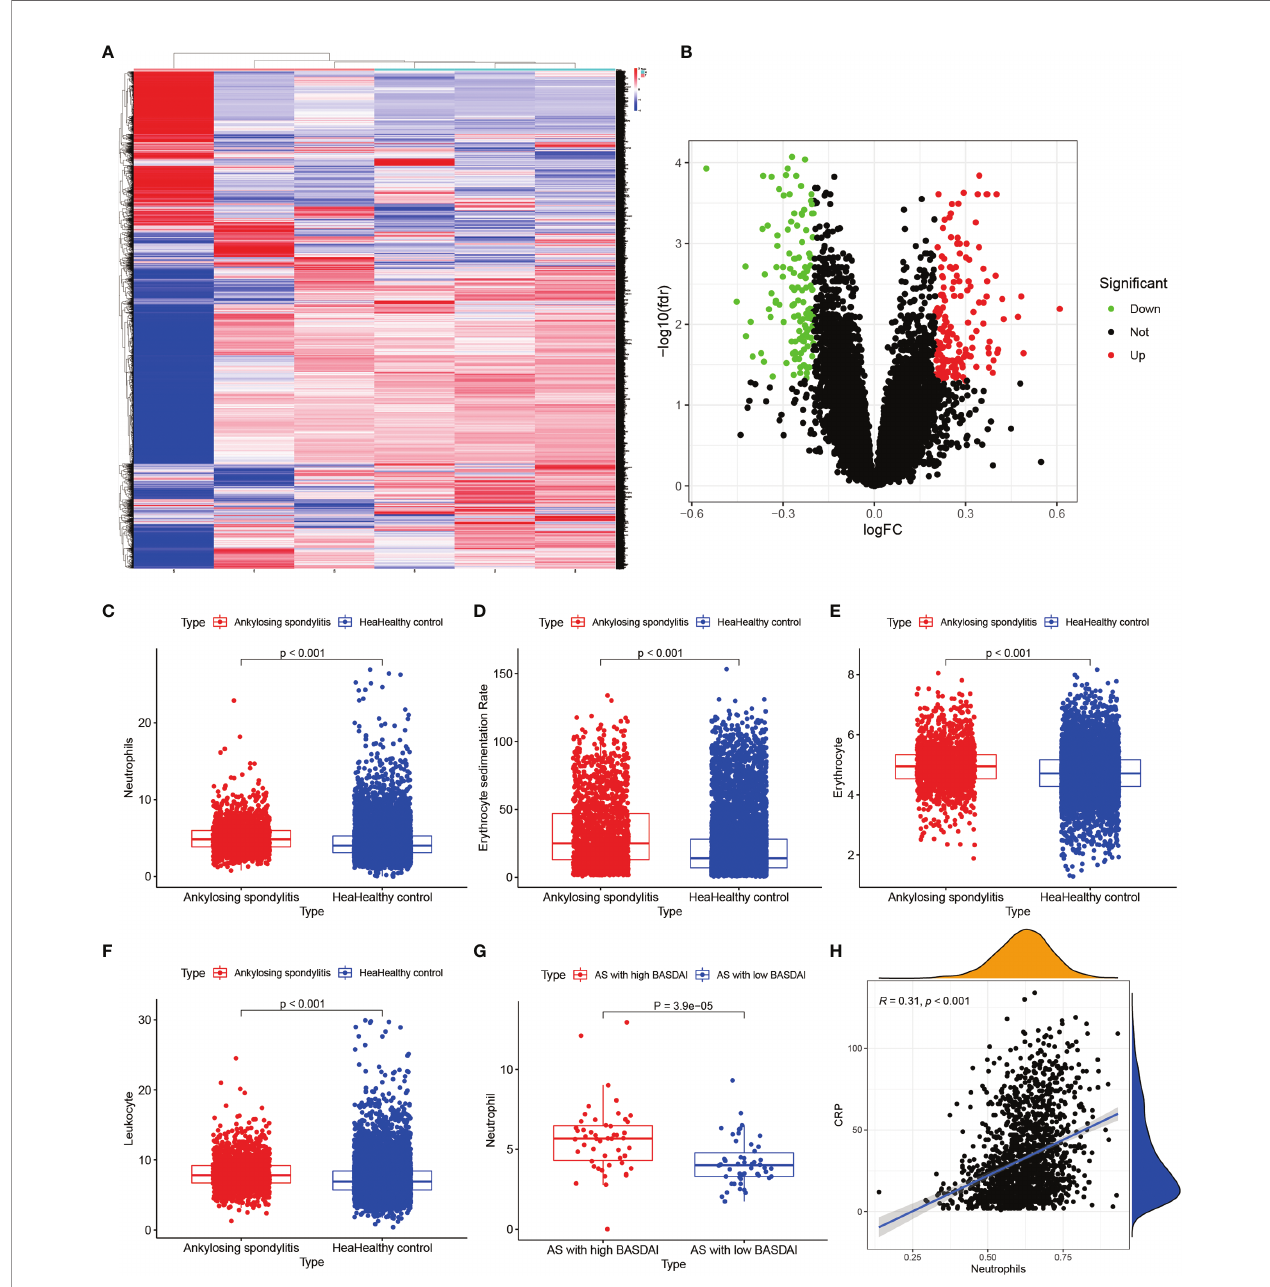
FIGURE 9 | Results of external validation sets are shown. (A, B) show heat and volcano maps of differentially expressed genes measured by high-throughput sequencing, con fi rming that ANXA3 and SORL1 are also differentially expressed genes in the interspinous ligament of AS. (C-F) show the variance analysis of the routine blood tests. (G) shows the difference in neutrophils between high BASDAI cases and low BASDAI cases. (H) shows the relationship between neutrophils and